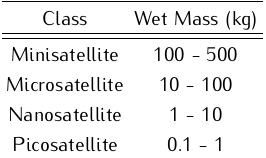
Table 1. Classification of Small Satellites.